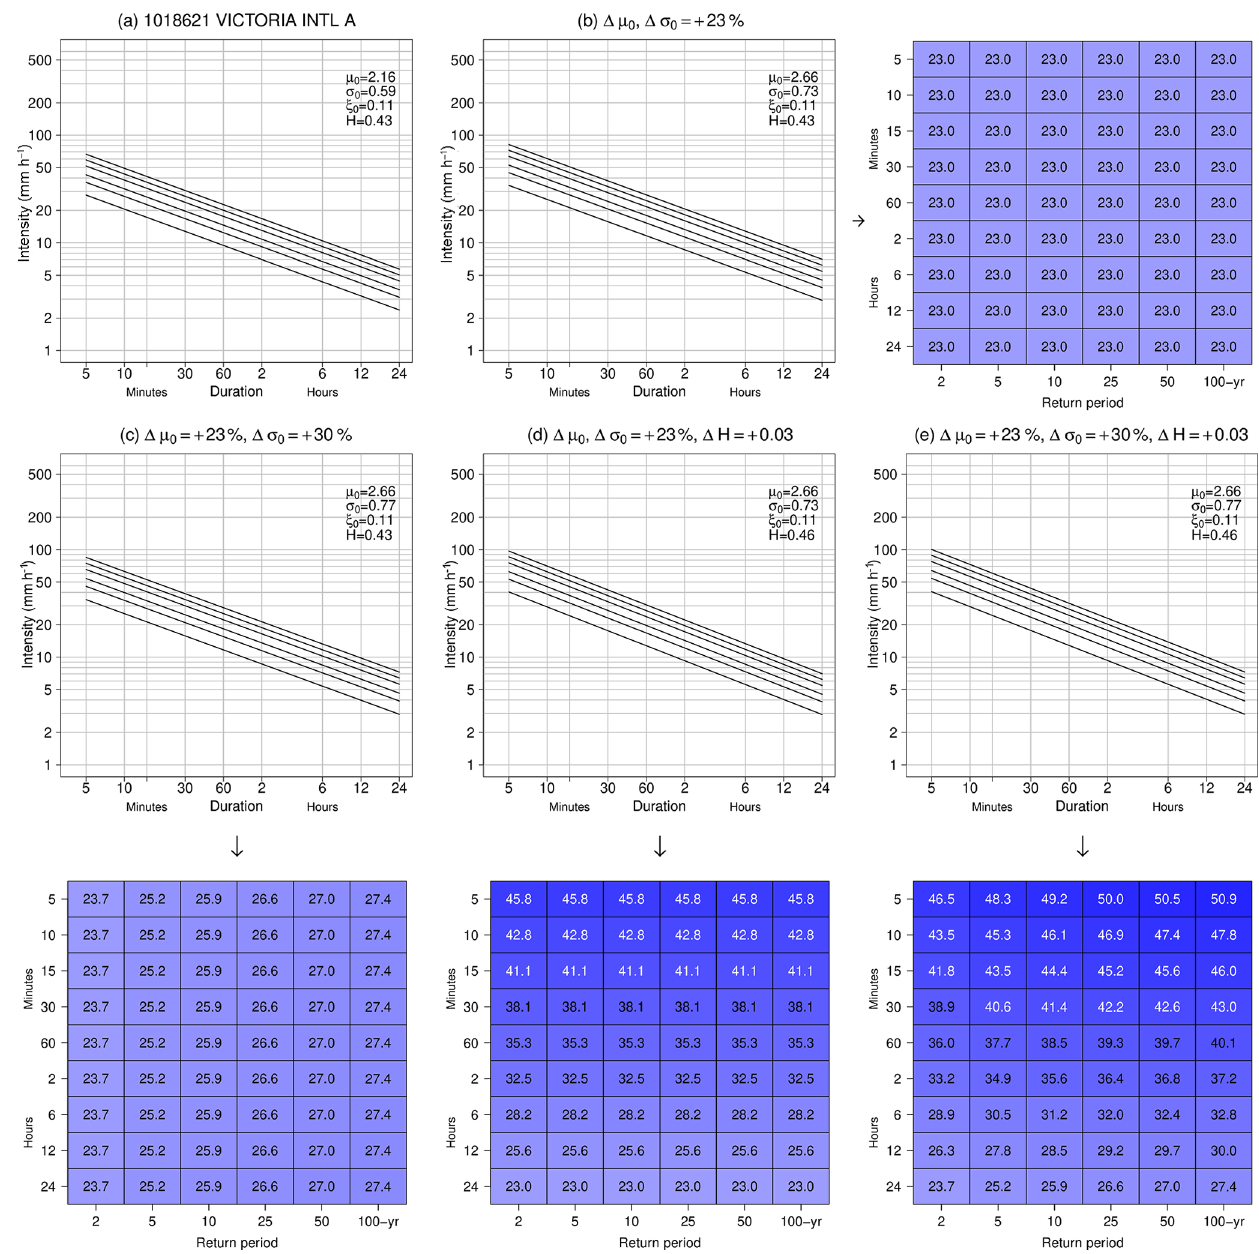
Figure 3. (a) Observed GEVSS IDF curves at Victoria Intl. A. (1018621) (see Fig. 2). Hypothetical IDF curves resulting from (b) increases of (cid:49)µ 0 = + 23% and (cid:49)σ 0 = + 23% (i.e., no change in dispersion σ 0 /µ 0 ); (c) increases of (cid:49)µ 0 = + 23% and (cid:49)σ 0 = + 30% (i.e., an increase in dispersion σ 0 /µ 0 ); (d) increases of (cid:49)µ 0 = + 23%, (cid:49)σ 0 = + 23%, and (cid:49)H = + 0 . 03; and (d) increases of (cid:49)µ 0 = + 23%, (cid:49)σ 0 = + 30%, and (cid:49)H = + 0 . 03. The matrix plots that accompany (b–d) show the associated percentage changes in return levels for each duration: (b) with constant H , increasing µ 0 and σ 0 without changing the dispersion leads to relative increases in return levels for all durations that match the relative changes in the underlying parameters; (c) increasing dispersion leads to return period dependence of changes, with larger relative increases evident at longer return periods; (d) increasing H steepens the IDF curves, which leads to duration dependence of changes; and (e) increases in both H and dispersion result in greater intensification at longer return periods and shorter durations. Note that values in (e) are based on domain mean values from Sect.